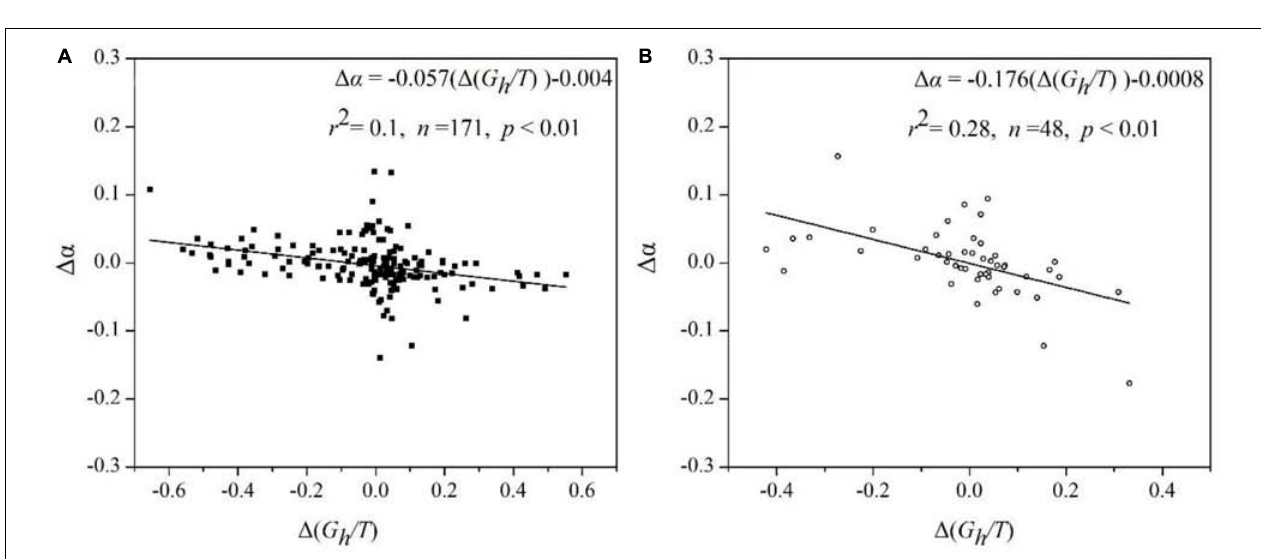
FIGURE 9 | The changes in albedo ( (cid:49) α ) between successive half hour vs. the corresponding changes in diffuse portion of shortwave incident radiation, (cid:49) ( G h /T ) over ice (A) and snow (B) between 26 June and 2 August 2007.